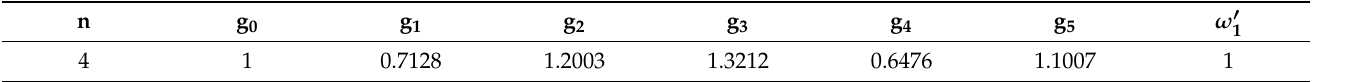
Table 1. Chebyshev coefficients of a 4th-order filter for a 0.01 dB ripple.